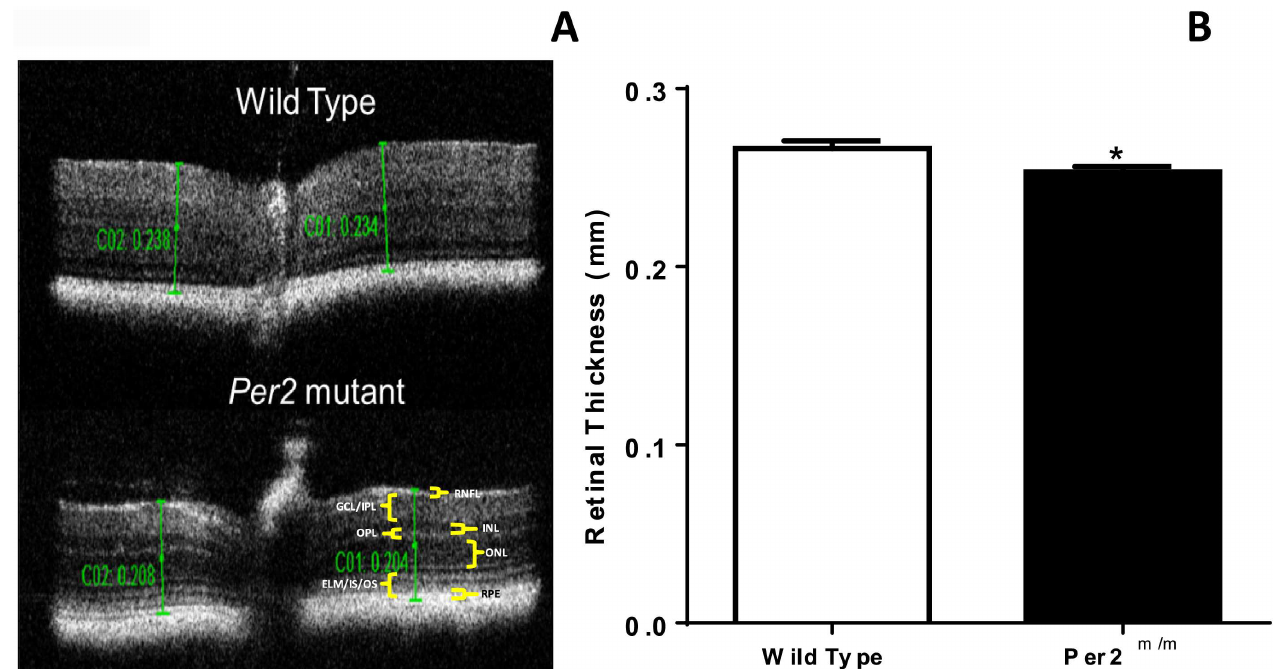
Fig 2. Per2 m/m mice show a decreasein retinal thickness. (A) The OCT scans of the whole retina showingrepresentative images from the WT and Per2 m/m mice. RNFL, retinal nerve fiber layer; GCL/IPL, Ganglioncell layer/innerplexiform layer; INL, Inner nuclearlayer; OPL, Outer plexiform layer; ONL, Outer nuclear layer; ELM/IS/OS, external limiting membrane/inner segment of photoreceptors/outer segment of photoreceptors; RPE, Retinal pigment epitheliallayer. (B) The measurements of retinal thickness were performed by placing the 2 calipers (C01 & C02) near the optic nerve; the bar chart shows a decrease in retinal thickness of Per2 m/m . n = 6, * p <